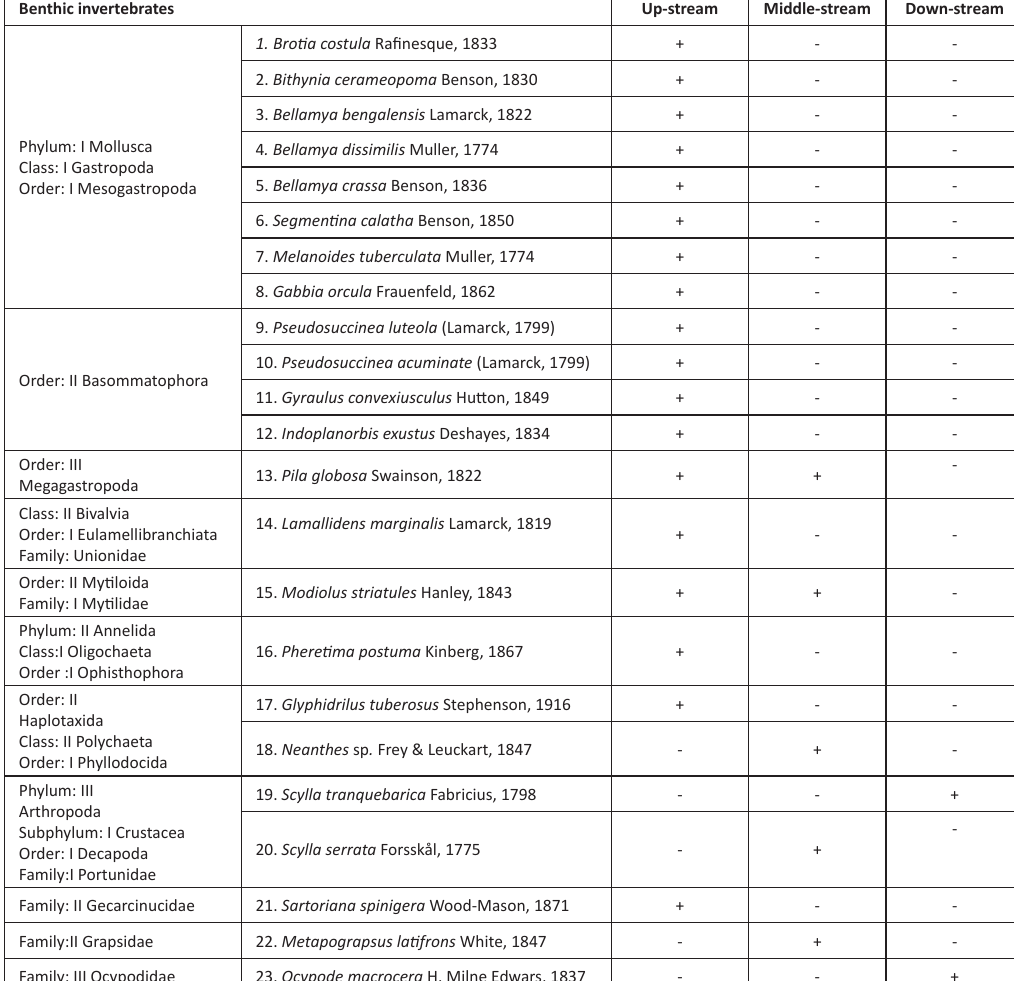
Table 3. Distribution of benthic invertebrates in Ichamati Benthic invertebrates Up-stream